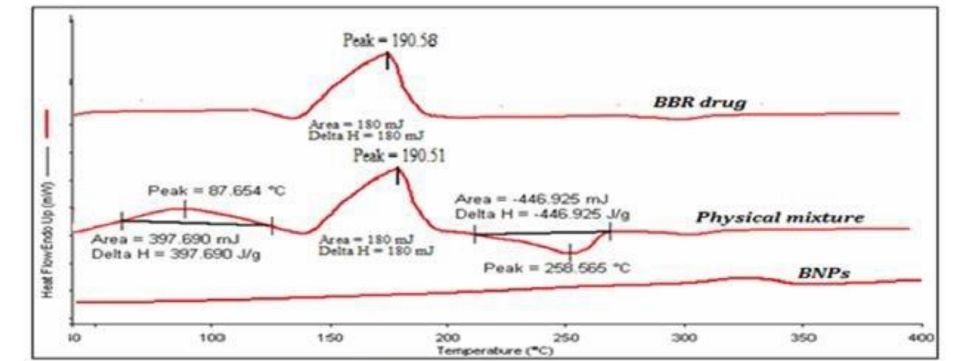
Figure 2. DSC thermograms of BBR, physical mixture, and BNPs.